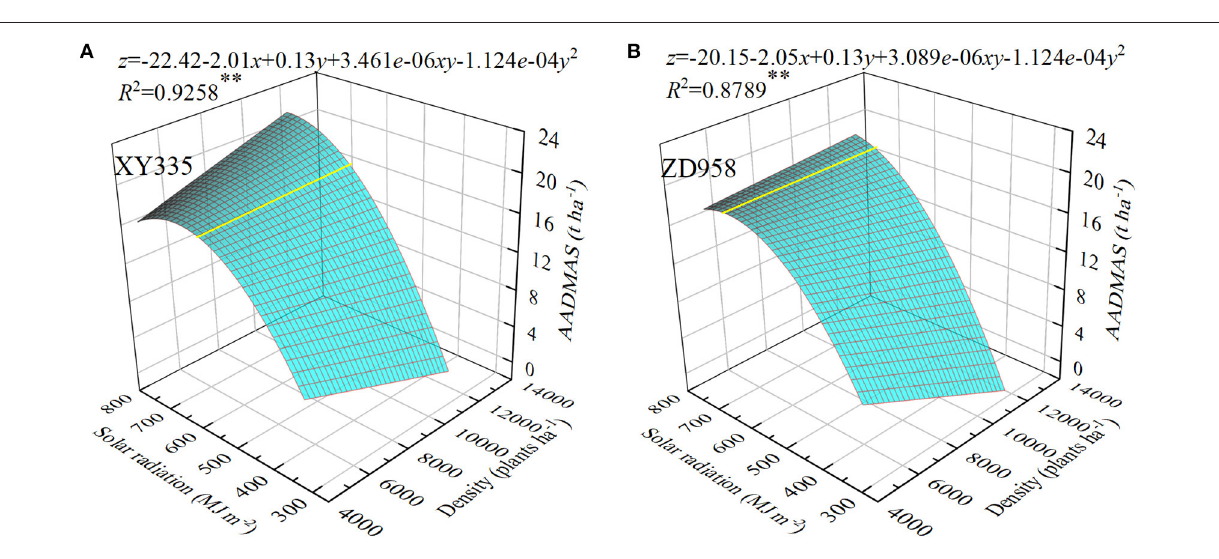
FIGURE 2 | Relationships between assimilation amount of dry matter after silking (AADMAS), planting density, and different totals of accumulated photosynthetically active radiation from the silking to the maturity stages in two maize hybrids (XY335 and ZD985). x is planting density, y is solar radiation, z is AADMAS. ** P ≤